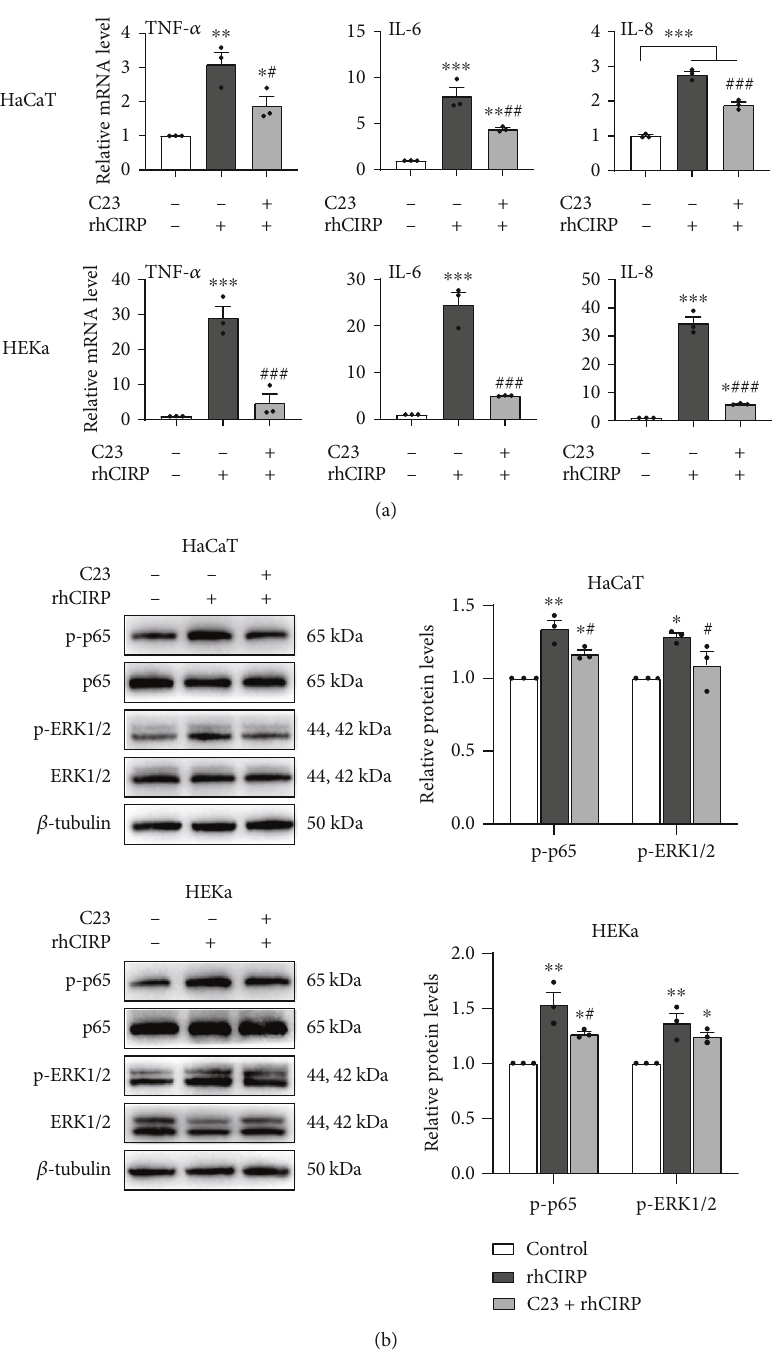
Figure 4: C23 inhibited the eCIRP-induced upregulation of proin fl ammatory cytokine expression and activation of signaling pathways. (a) C23 inhibited TNF- α , IL-6, and IL-8 production in HaCaT and HEKa cells stimulated with rhCIRP. Cells were pretreated with 1 μ g/ml C23 for 30 minutes and then were incubated with 1 μ g/ml rhCIRP for 1 hour. RNA was extracted for analysis by qRT-PCR. (b) C23 inhibited the phosphorylation of NF- κ B p65 and ERK1/2 in HaCaT and HEKa cells stimulated with rhCIRP. Cells were pretreated with 1 μ g/ml C23 for 30 minutes and then were incubated with 1 μ g/ml rhCIRP for 1 hour. Cells were lysed for western blot analysis of the indicated proteins. The phosphorylation of NF- κ B p65 and ERK1/2 was analyzed by western blot analysis. Data are expressed as the mean ± SEM . n = 3 /group. ∗ P < 0 : 05 , ∗∗ P < 0 : 01 , and ∗∗∗ P < 0 : 001 vs. control; # P < 0 : 05 , ## P < 0 : 01 , and ### P < 0 : 001 vs. rhCIRP